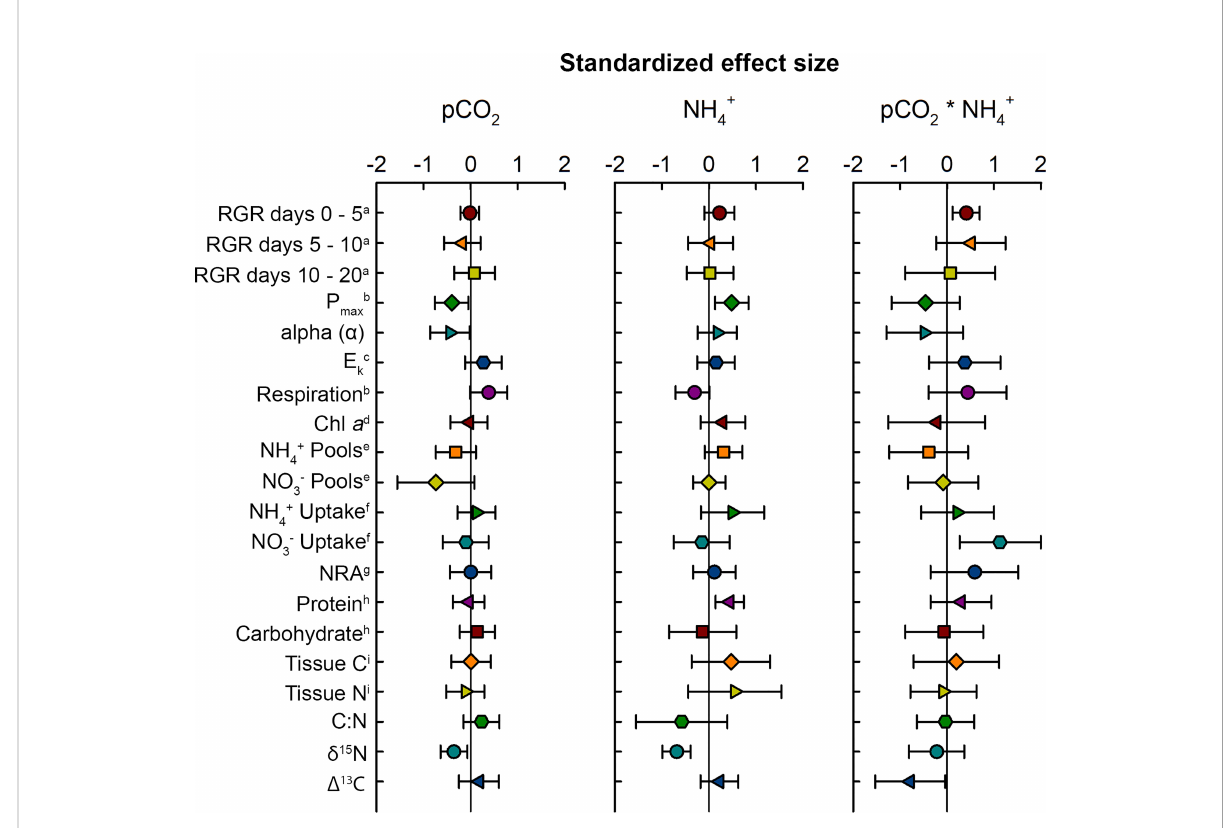
FIGURE 2 Standardized effect sizes for physiological responses of Ulva lactuca to pCO 2 and NH 4+ enrichment. The effect sizes were calculated as the weighted average of standardized coef fi cients from each model in the set where the term appears. Error bars are 95% con fi dence intervals. a